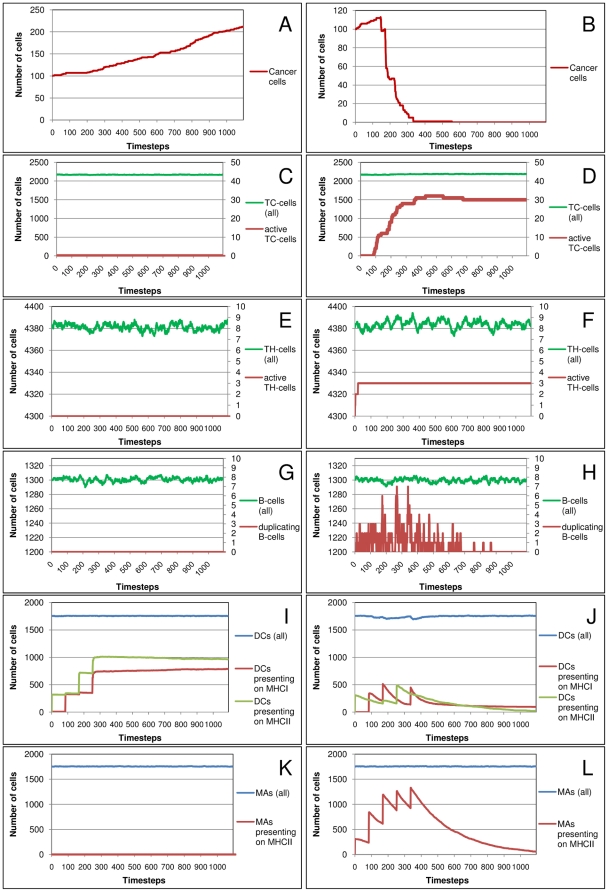
Peptide Vaccination With and Without Adjuvant.Cell counts are depicted for cancer cells (A/B), cytotoxic T-cells (C/D), helper T-cells (E/F), B-cells (G/H), dendritic cells (I/J) and macrophages (K/L) over one year of simulated time. One time step equals 8 hours. Left panel: No adjuvant was added; right panel: Adjuvant was included. For both experiments one hundred initial cancer cells were simulated within 5 µl of blood that were treated with peptide injections starting at time point zero and being repeated five times at an interval of 28 days. The MHC-genotype of this virtual individual is HLA_A80/HLA_B56/HLA_DQA2_DQB2/HLA_DRB3. The antigen A2SUH6_HUMAN (Survivin variant 3 alpha) was chosen from over-expression data in prostate tumors. Two MHC I-binding peptides and two MHC II-binding peptides were injected.